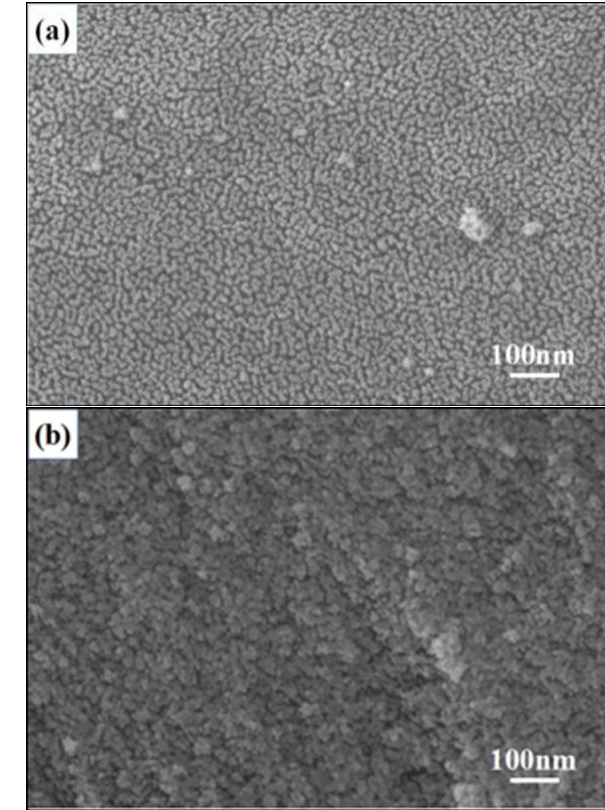
Figure 2: SEM photograph of colloidal silica without (a) and with MgO (b) after curing for 24 hours at 30 ∘